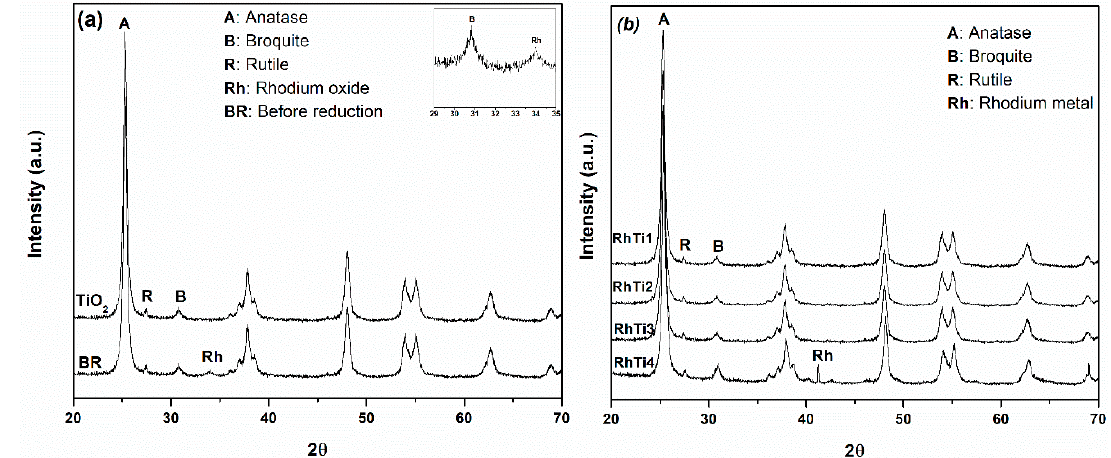
Figure 2. X-ray diffraction patterns of ( a ) TiO 2 and catalyst before to reduction, ( b ) RhTi1, RhTi2 and RhTi3 and RhTi4 catalysts.